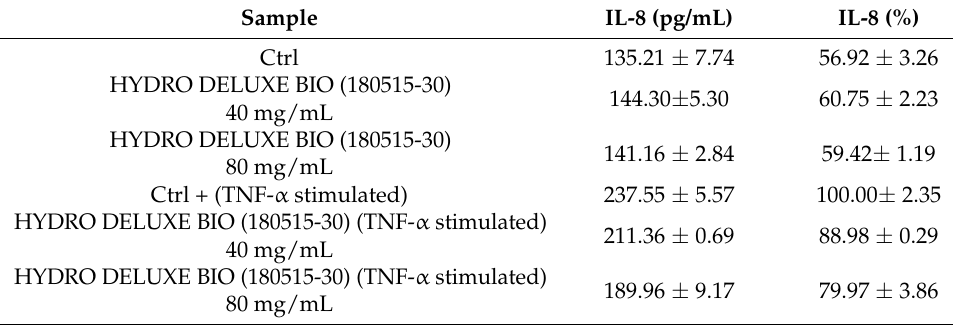
Figure 1. HYDRO DELUXE BIO treatment induces a decrease in IL-8 levels after TNF- α stimulation. The expression levels of IL-8 were determined in HaCat cells by ELISA assay. Values are expressed as concentration in pg/mL ( a ) and as percentage ( b ) on HaCaT cells. Ctrl: untreated cells; 40: cells treated with HYDRO DELUXE BIO 40 mg/mL; 80: cells treated with HYDRO DELUXE BIO 80 mg/mL; Ctrl+: untreated cells + TNF- α ; HYDRO DELUXE BIO: cells treated with 40 or 80 mg/mL + TNF- α . Values of ** p ≤ 0.01 were considered highly significant compared with Ctrl+ by one-way ANOVA statistical analysis. Table 1. Values of IL-8 levels, expressed as concentration and percentage (mean ± SD), in cells after treatment with the product HYDRO DELUXE BIO.